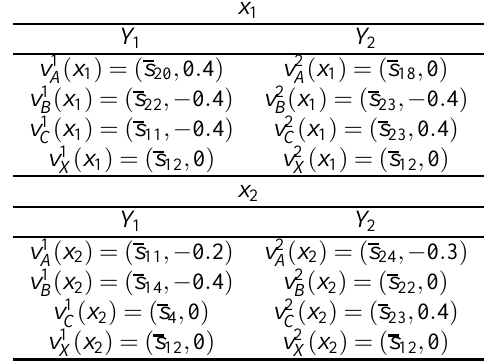
Table 6. Reviewers’ collective criteria values for each employee